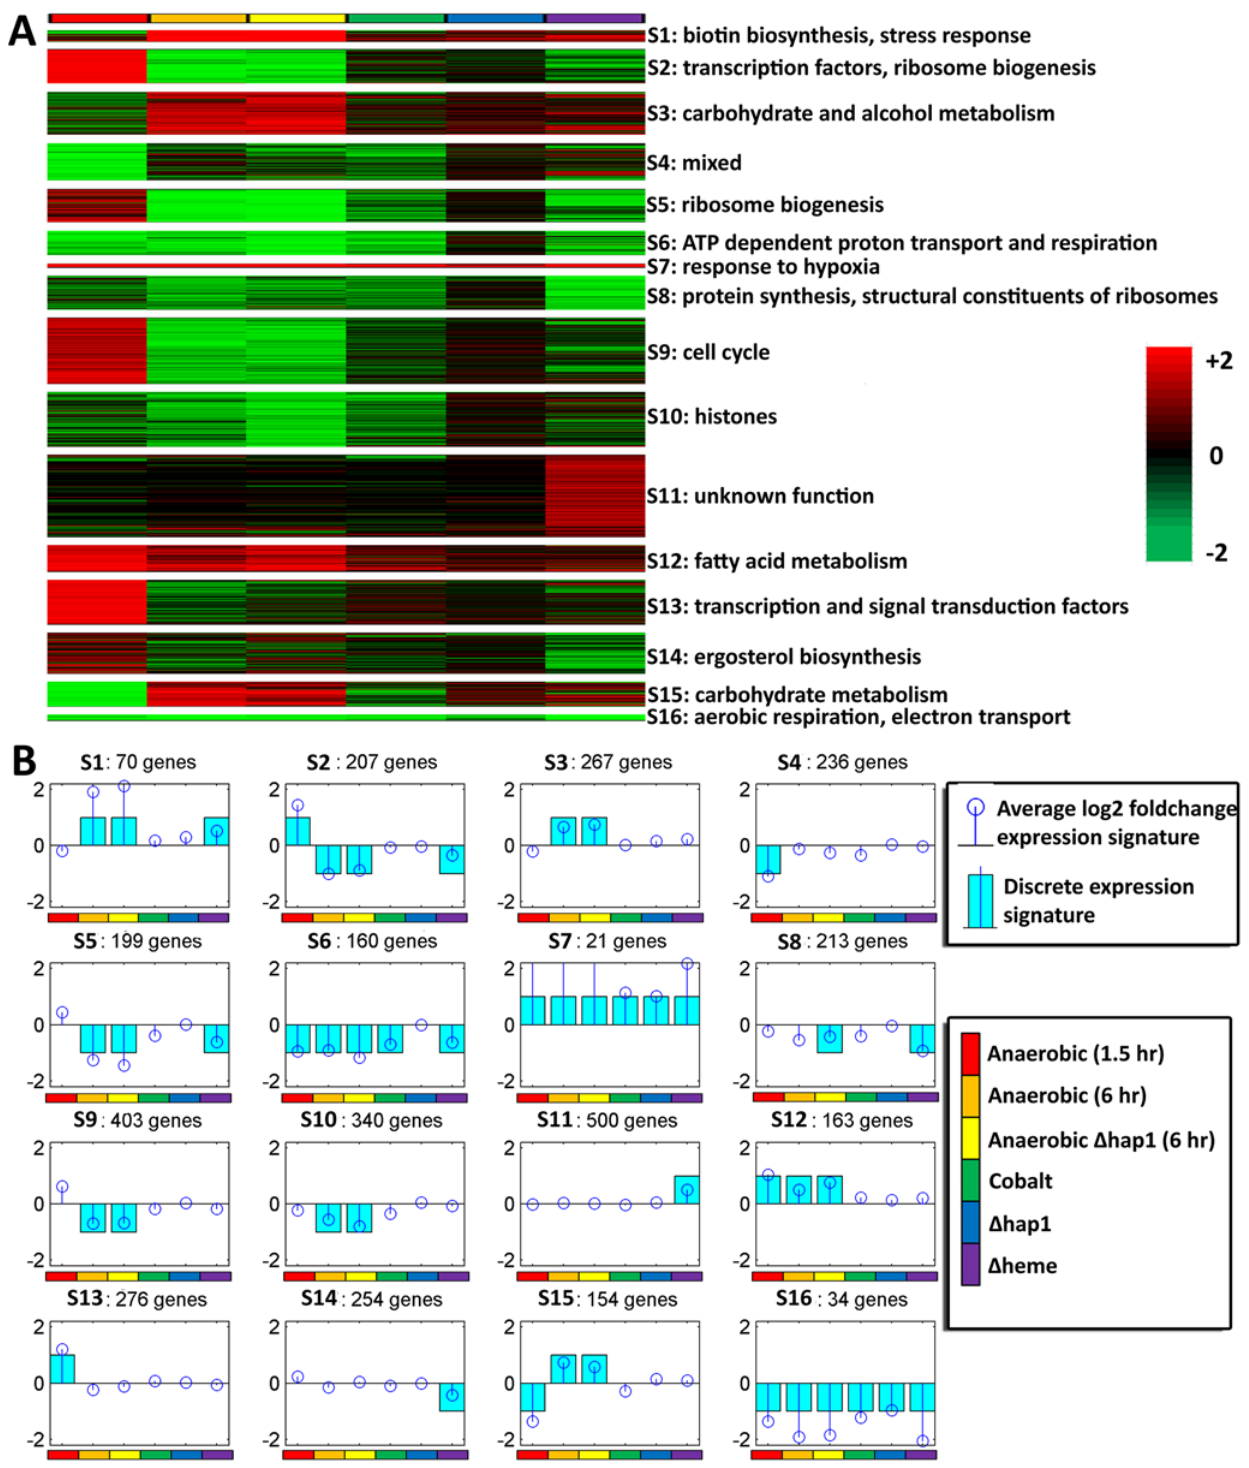
Figure 1. Expression signatures identified by perturbation of the oxygen regulatory network. (A) Heat maps showing real-valued expression profiles of genes that are members of the 16 signatures identified. The expression values are in log 2 . The rows represent genes and the columns represent the 6 experimental conditions. Bright red indicates strong upregulation, bright green indicates strong downregulation, and black indicates no change in expression. Each signature is labeled with statistically significant functional annotations. (B) Each block displays the average real-valued expression (stem plot in dark blue) and discrete expression profile (bar plot in light blue) for each signature over the 6 experimental conditions. The real-valued expression values are in log 2 .